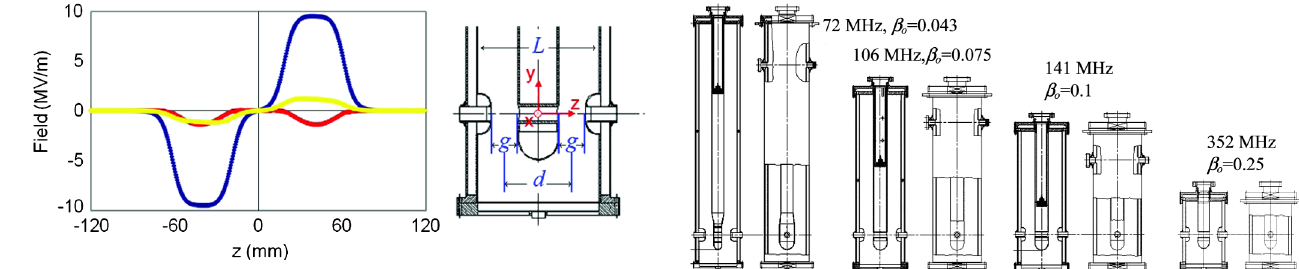
FIG. 3. Examples of INFN-TRIUMF type QWR design for ð z Þ ; red: E ð z Þ (cid:4) 10 ; yellow: z y . Cavities with similar cavities with different frequency and (cid:1) o ¼ 0 : 047 to (cid:1) ¼ 0 : 13 , are in use in several geometry, from (cid:1) o o superconducting heavy ion